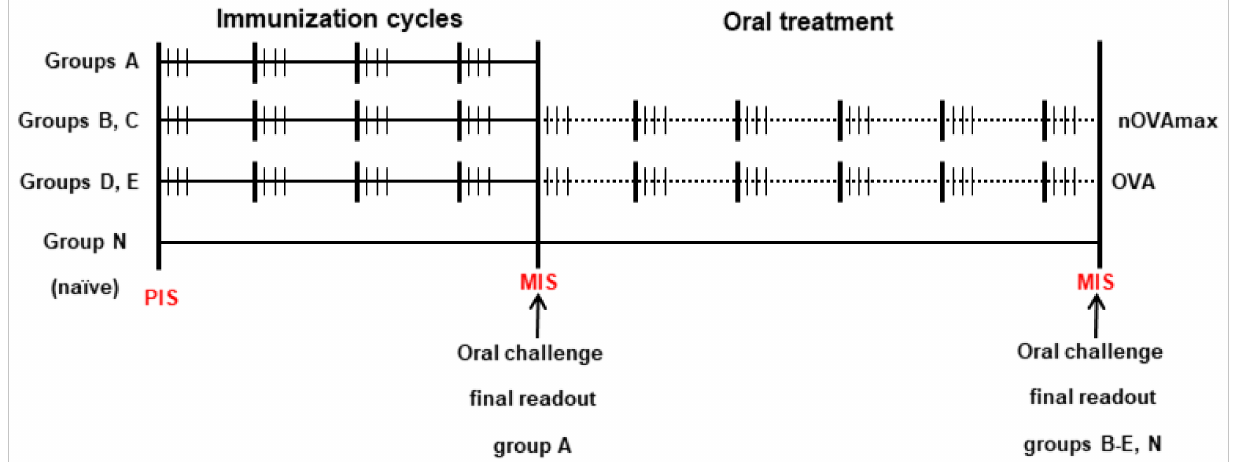
Figure 1. Mouse treatment protocol. One immunization/oral treatment cycle lasts 2 weeks. The bold lines in this figure indicate the start of a 2-week cycle. Immunization cycle: On days 1, 2 and 3, the mice of groups A, B and D received omeprazole intravenously. On days 2 and 3, the mice of the same groups were fed with OVA and sucralfate. Groups C, E and N did not undergo immunization. Oral treatment cycle: On days 1, 2 and 3 of each cycle, groups B and C received nOVAmax, groups D and E received OVA, groups A and N received no therapy. Abbreviations used: PIS—preimmunization serum; MIS—mouse immunization serum; nOVAmax—maximally nitrated ovalbumin;